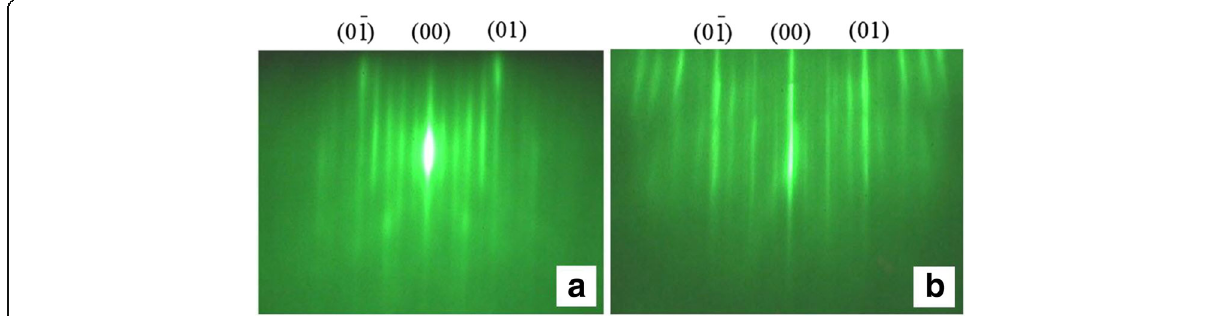
Fig. 4 Superstructures observed at the Si growth on the GeSiSn layer in the multilayer periodic structure in the azimuthal [110] direction: a (5×1) and b (10×1)